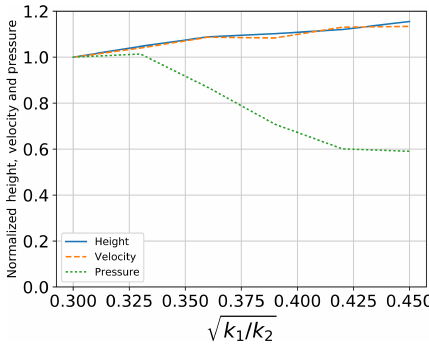
Figure 12. Variation in flow height, velocity and pressure for dif- √ ferent values of the adhesive stiffness parameter ( k c ) when nor- k 1 /k 2 ) when √ malized by results of the simulation with φ b = 30 ◦ , k 1 /k 2 = d 50 = 75mm and α = 30 ◦ .